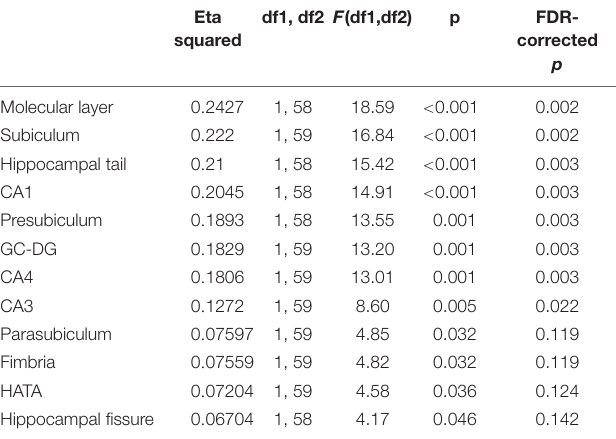
TABLE 2 | Differences in hippocampal subfield volumes between risk